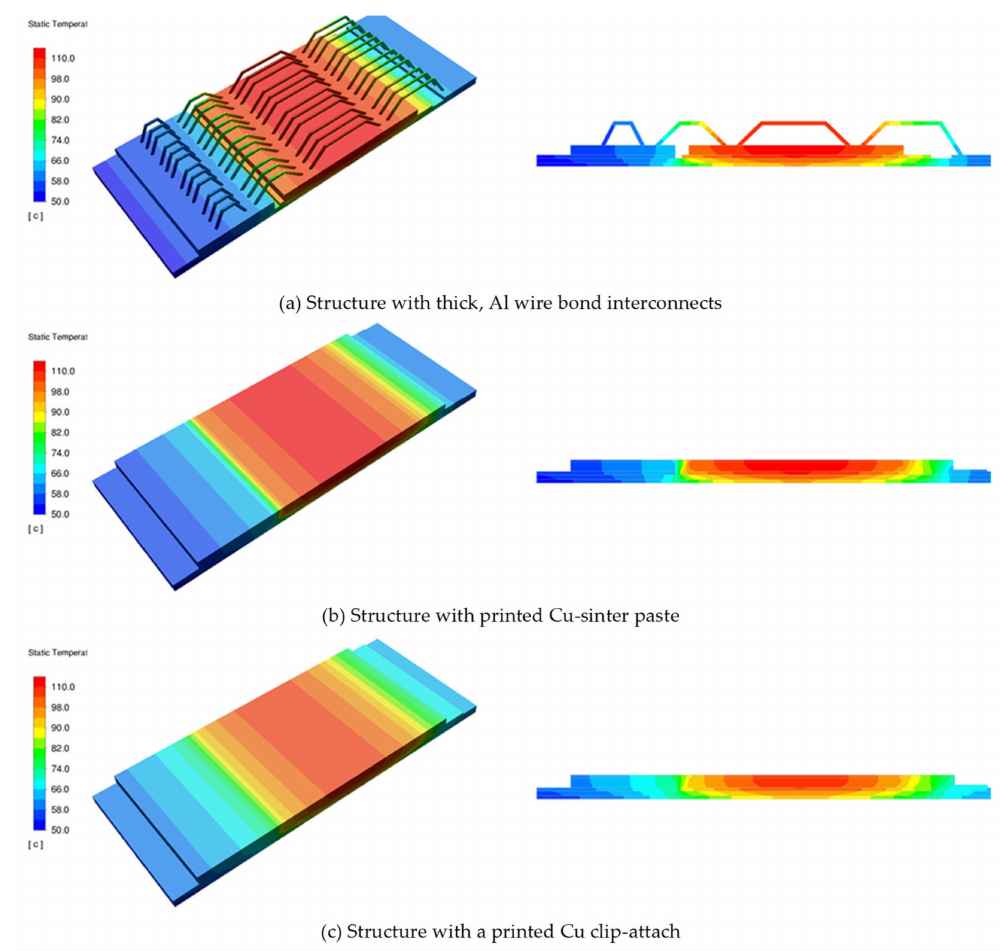
Figure 10. Finite element-computed temperature distributions for the three presented structures at 100 W IGBT power